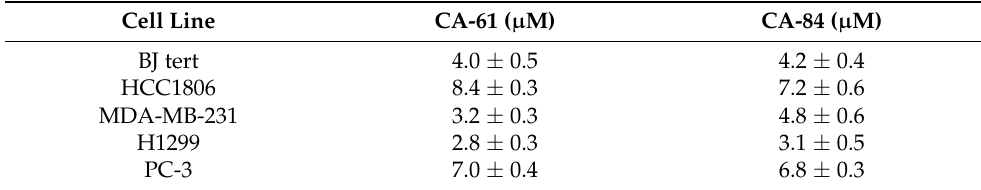
Table 2. IC 50 values for CA-61 and -84 in non-transformed human fibroblasts (BJ tert) and epithelial cancer cell lines.